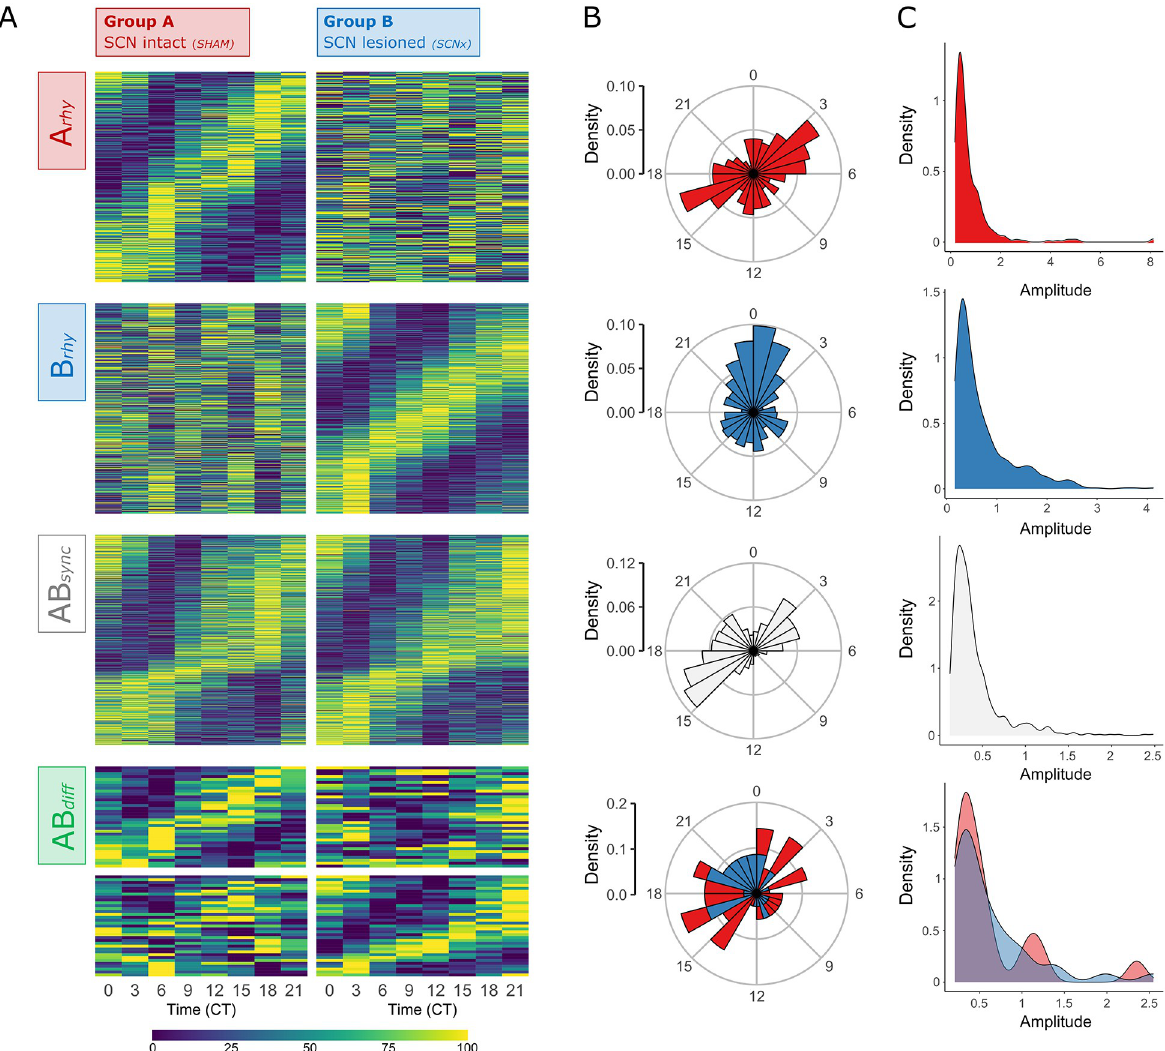
Fig 5. Circadian parameters of rhythmically expressed genes in the E19 fetal rat SCN. (A) Heatmaps of gene subsets identified by dryR depending on presence/absence of rhythmicity in either or both experimental groups. Transcripts classified as nonrhythmic in both groups and unclassified transcripts (BICW < 0.5) are not visualized (see S3 Data). Transcripts rhythmic in Group A (left), but not in Group B (right), or vice versa, were assigned to Model Arhy ( n = 301) and Brhy ( n = 518), respectively. ABsync ( n = 644) includes transcripts rhythmic in both groups with similar phase and/or amplitude, and ABdiff ( n = 35) with different phase and/or amplitude, respectively. Heatmaps of normalized rhythmic mRNA levels in the fetal SCN at 3-hour interval for Groups A (left) and B (right). (B) Phase and (C) amplitude distribution of transcripts classified as rhythmic within the respective dryR models (for ABdiff –Group A: red, Group B: blue). For raw data, see NCBI’s GEO no. GSE183172 and S3 Data. BICW, Bayes information criterion weight; SCN, suprachiasmatic nuclei.